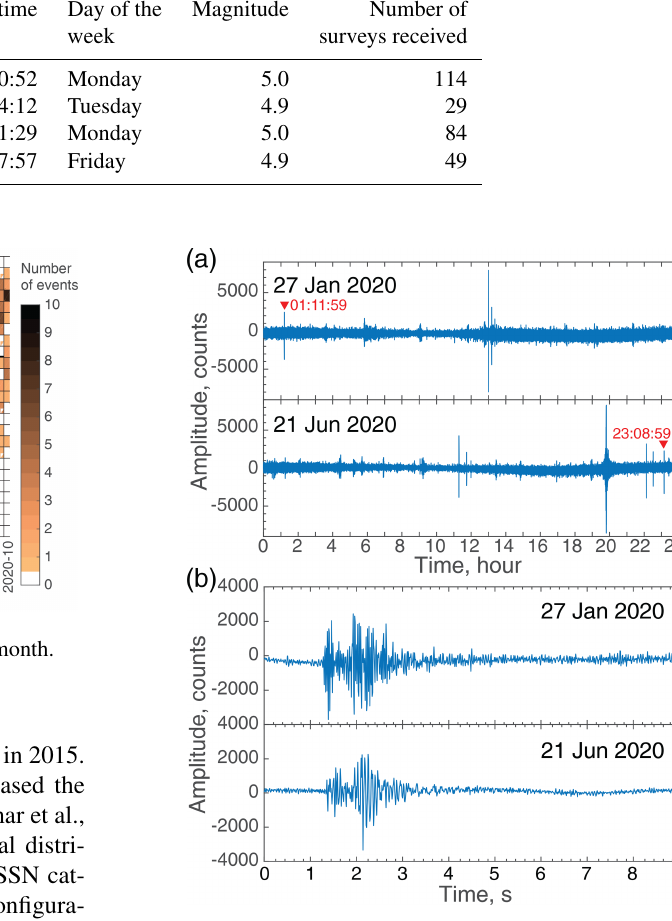
Figure 6. Record comparison for a day with the usual (top panels, 27 January 2020) and reduced (lower panel, 21 June 2020) seis- mic noise at station ZAIG. (a) 24h record. (b) Event window. Both events are M